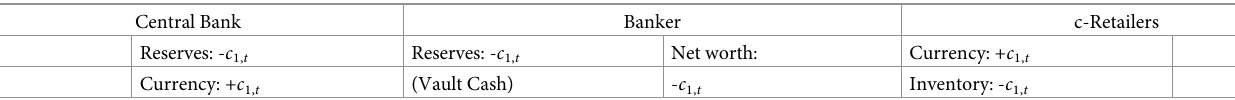
Table 5. Banker buys goods from c-retailers.